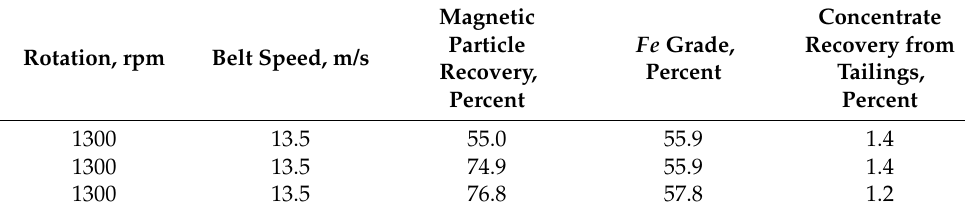
Table 6. Magnetic cleaner separation parameters.